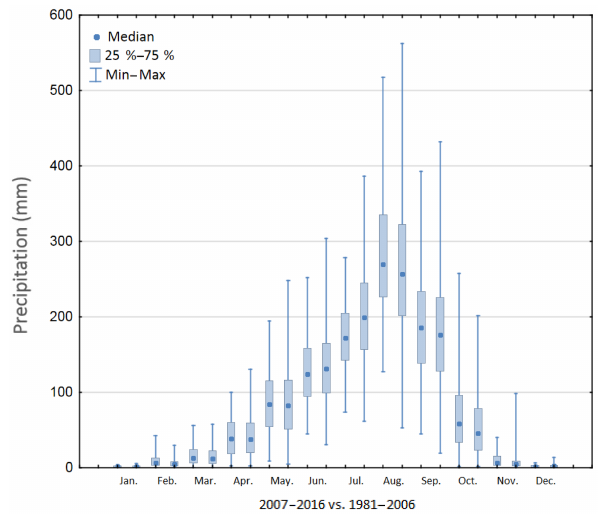
Figure 2. Box–whisker plot comparison (top) of monthly precipita- tion for the first 25 years of the time series versus the last 10 years (2007–2016 vs. 1981–2006). On the bottom, the results of the sea- sonal Mann–Kendall (MK) test for detecting significant increasing or decreasing trends (Kendall score) in the precipitation patterns for each of the areas taken into consideration in this study. The MK test was conducted using the observed precipitation records of the most recent time period (2007–2016) and the full time series available (1981–2016). The test performed did not highlight statistically sig- nificant (significance threshold p value < 0.010) increasing or de- creasing trends in the analysis of the two precipitation time